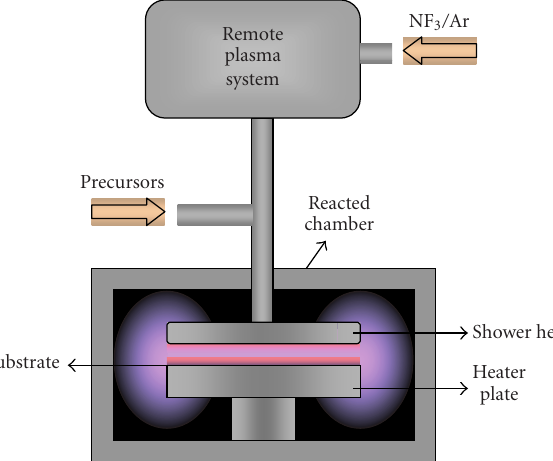
Figure 2: Schematic of the PECVD chamber with an RPS system in this experiment. The gases are injected into the reacted chamber through the shower head, and the substrate is placed in the center of a heater